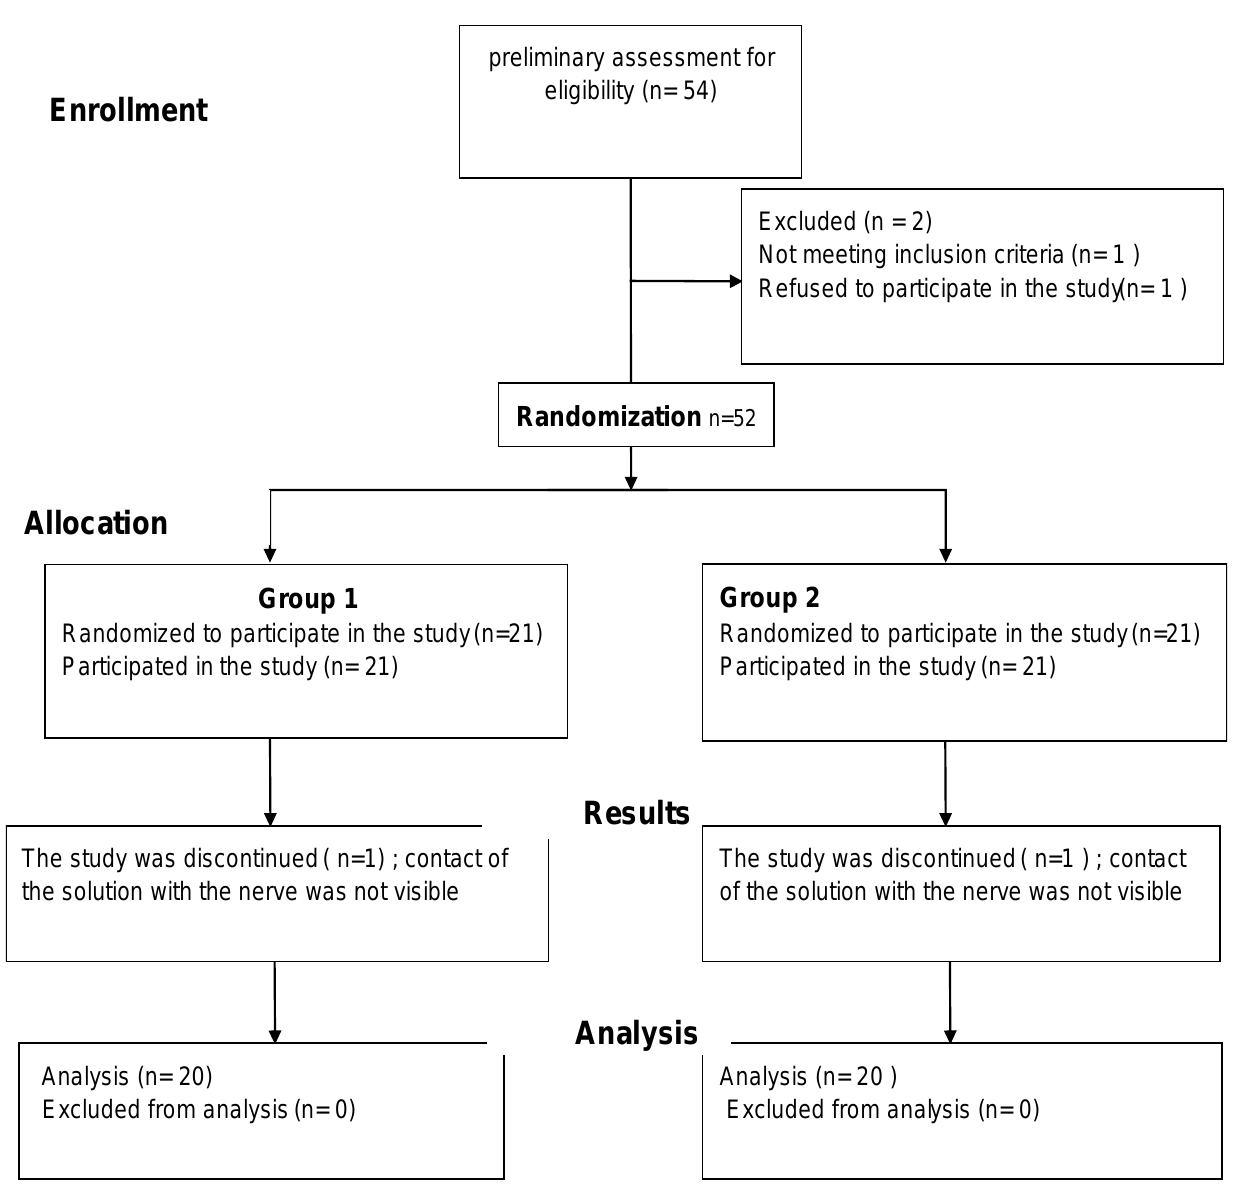
Figure 1. The study design.